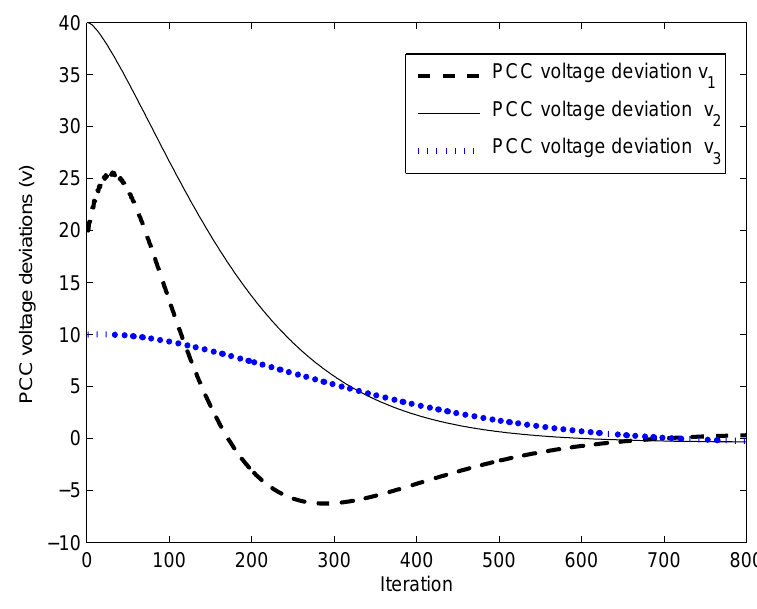
Figure 17. PCC voltage control using the proposed control